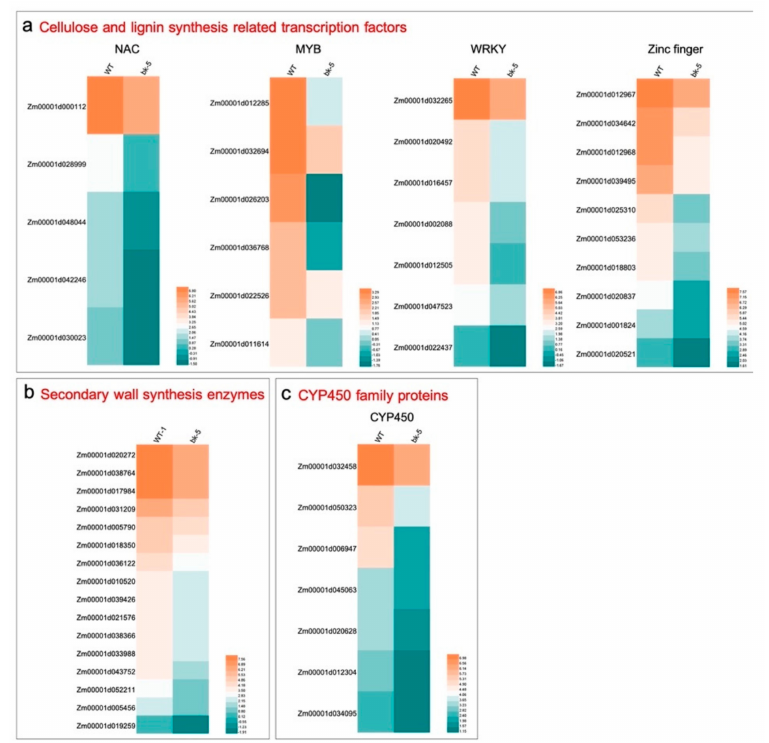
Figure 7. Some differentially expressed gene of bk-5 and WT. ( a ) Many cellulose and lignin synthesis related transcription factors were down-regulated. This includes NAC (NAM, ATAF1/2, CUC1/2 transcription factor), MYB (v-myb avian myeloblastosis viral oncogene homolog transcription factor), WRKY (transcription factor), and zinc finger. ( b ) Many secondary wall synthesis-related transferase enzymes were down-regulated, most of them were glycosyltransferase. ( c ) CYP450 (cytochrome P450) family proteins were also significantly down-regulated. Each row of the heat map represents the log2 fold values of a differentially expressed gene (green, low expression; orange, high expres- sion). Hierarchical grouping of differentially expressed genes shows clustering analysis by HEML. WT: